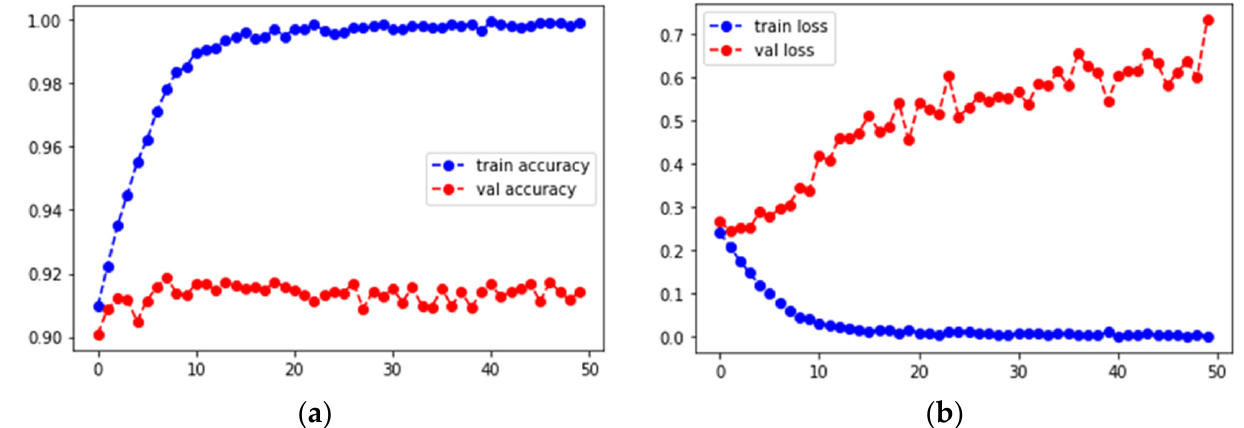
Figure 8. Training and testing of AlexNet + IDA model: ( a ) accuracy, ( b ) loss.